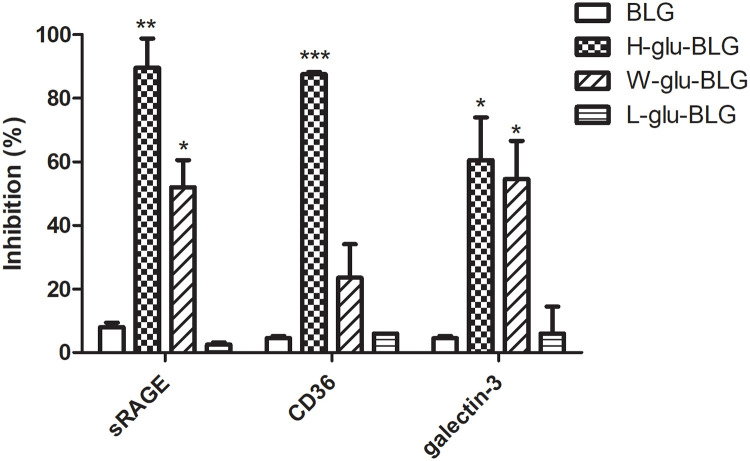
Heat-treatment in the presence of glucose confers receptor binding capacity to BLG.BLG was untreated or heated (W, H or L) in the presence of glucose (glu) and the soluble fraction was used to inhibit the binding of receptor to a positive control in the inhibition ELISA. Data shown are the mean values ± SD of n = 4 based on measurement of 2 parallel prepared samples. Statistically significant differences between native and processed BLG for each receptor was determined using unpaired two-tailed t-Test, *p < 0.05, **p < 0.01, ***p < 0.001.